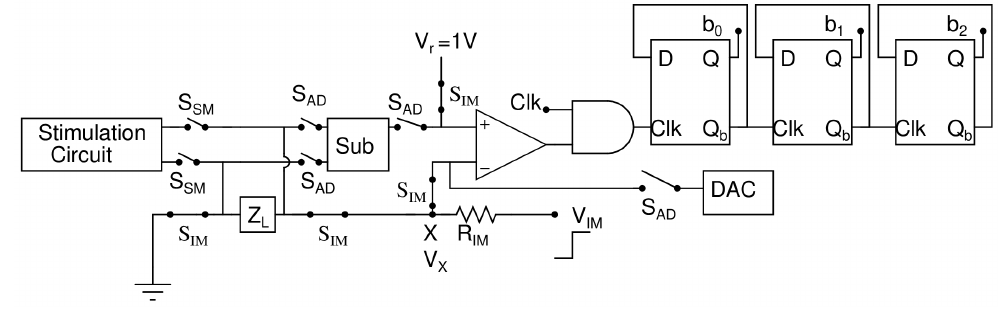
Figure 2. Circuit configuration of impedance measuring mode (IMM).